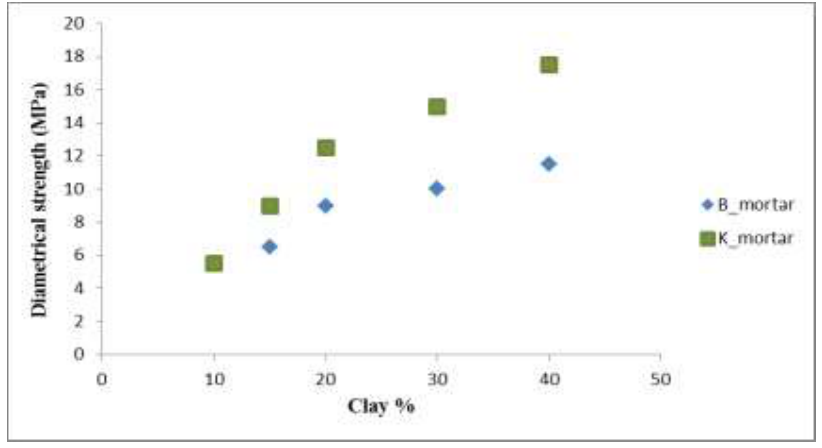
Figure 5: Diametric strength for K-mortar and B-mortar .